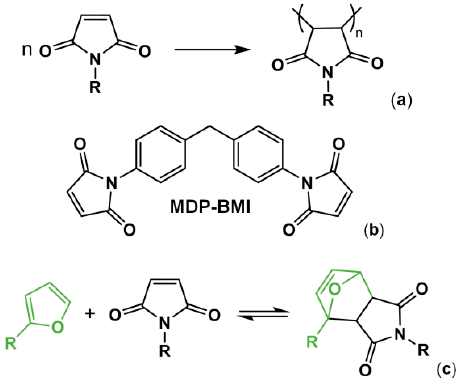
Figure 1. ( a ) Maleimide self-reaction into succinimide repetitive units. ( b ) MDP-BMI. ( c ) Diels- Alder (DA) thermo-reversible reaction between furan and maleimide.